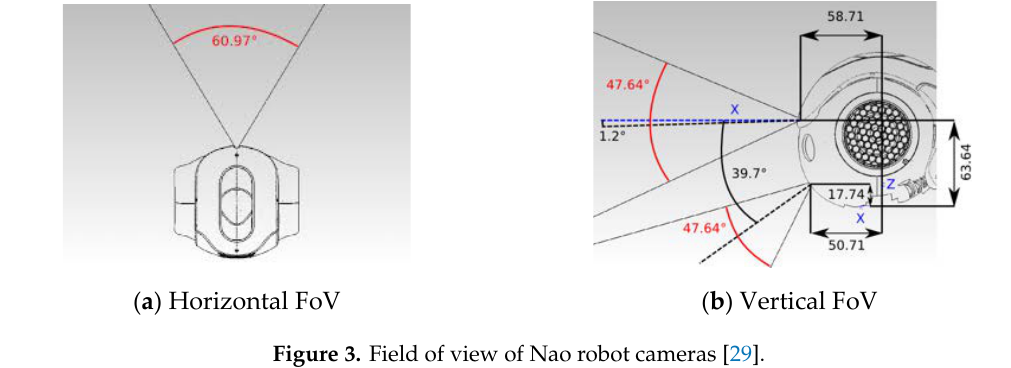
Figure 3. Field of view of Nao robot cameras [29].